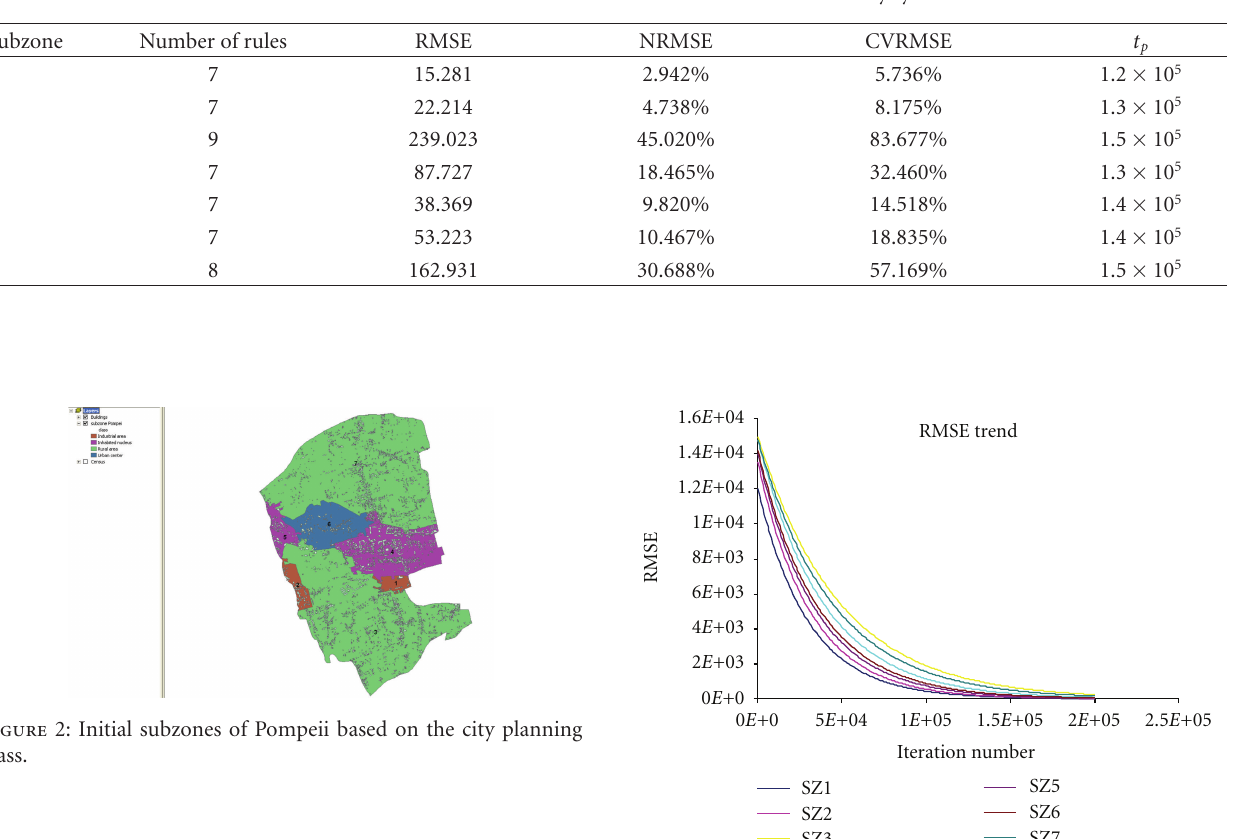
Figure 1: Schema of the subzones generation process. Table 2: Final number of rules and RMSE obtained for each TSK-fuzzy system.